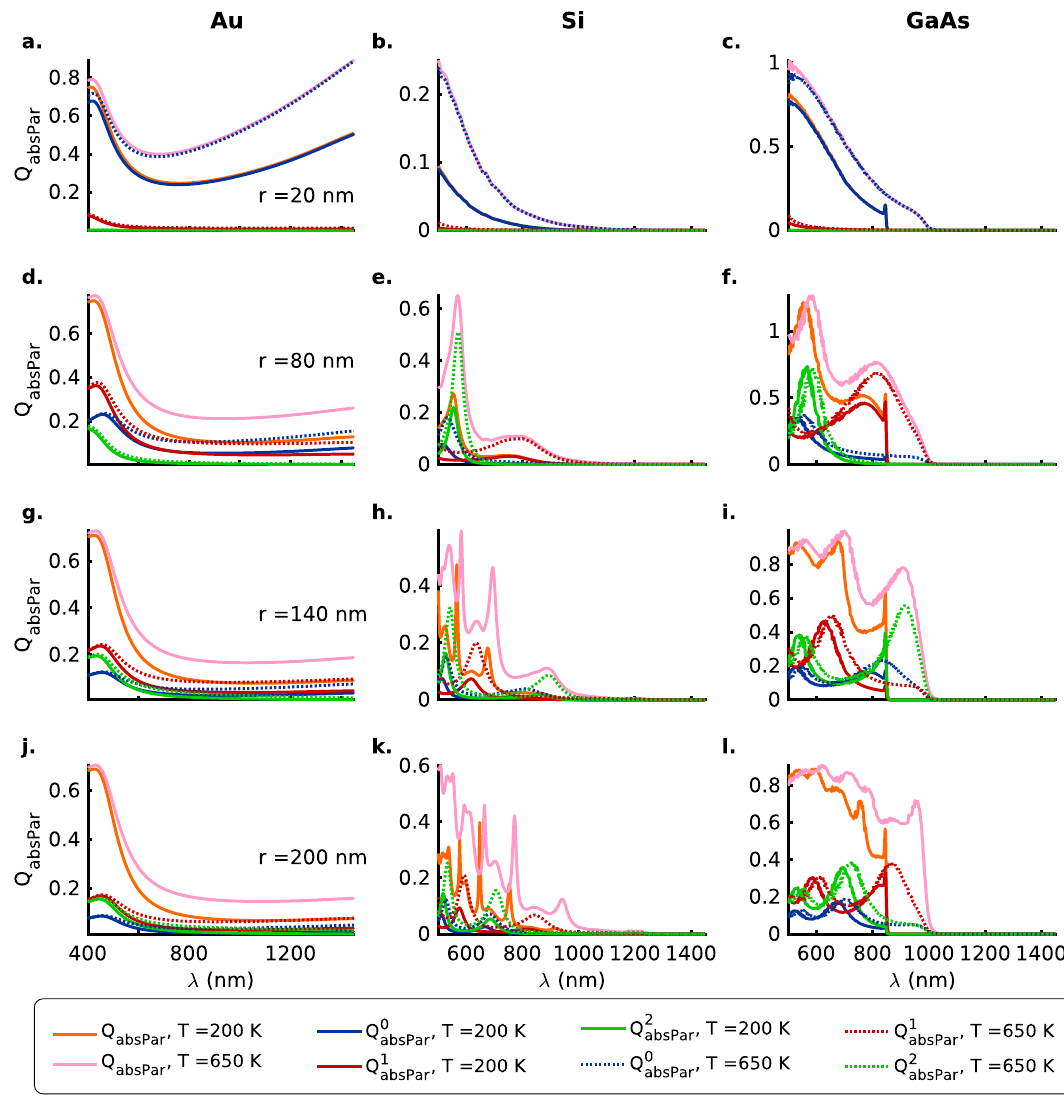
Figure 3. Mie absorption efficiency ( Q absPar ) for the TM ( E ) polarization of the incident radiation with zeroth (cid:31) (blue), first (red) and second (green) order contributions as a function of the wavelength (cid:31) for ( a , d , g , j ) Au 20, 80, 140 and 200 nm , respectively, at (DL model), ( b , e , h , k ) Si and ( c , f , i , l ) GaAs nanowires of radii r = 200 (solid lines) and 650 (dotted lines) K . The thick orange and pink solid lines represent temperatures T = 200 and 650 K , respectively. Here, the Mie the total absorption efficiencies, Q absPar , at temperatures T = computations for the nanowires of different sizes take into account their thermal expansion, although the text labels indicate the values for nanowire radii at 200 K . Also see Tables S4–S6 a in the Supporting Information for a summary of the spectral positions of the resonances, the contributing orders to the absorption resonances and the numeric values of the absorption efficiencies for the TM ( E ) (cid:31) (Fig. 3b) presents an absorption efficiency that is a fraction of the value for the GaAs nanowire (Fig. 3c). If one now considers the scattering efficiencies for the 20nm case, the two semiconductors exhibit comparable low (high) values of the scattering efficiency for the TE (TM) polarizations of the incident electromagnetic radiation (Figs. 1 and 2b, c). This implies that for unpolarized incident radiation the Si (indirect-bandgap) nanowires, in contrast to the GaAs (direct-bandgap) nanowires, shall function as highly efficient scatterers with a really low absorption cross-section. Unlike the case of scattering efficiencies for the TM and TE polarizations (Figs. 1 and 80nm are comparable in magnitude for the two 2), the absorption efficiencies for the thicker nanowires r ≥ polarizations for all materials considered here (Figs. 3 and 4d–l). mx 1 ), the Eqs. (12) and (15) for the Mie Thin wire limit. In the limit of a thin wire (size parameter, x and | | ≪ coefficients b 0 and a 0 corresponding to the zeroth-order modes for the TM and TE polarizations of the incident EM wave, respectively, can be approximated as 19